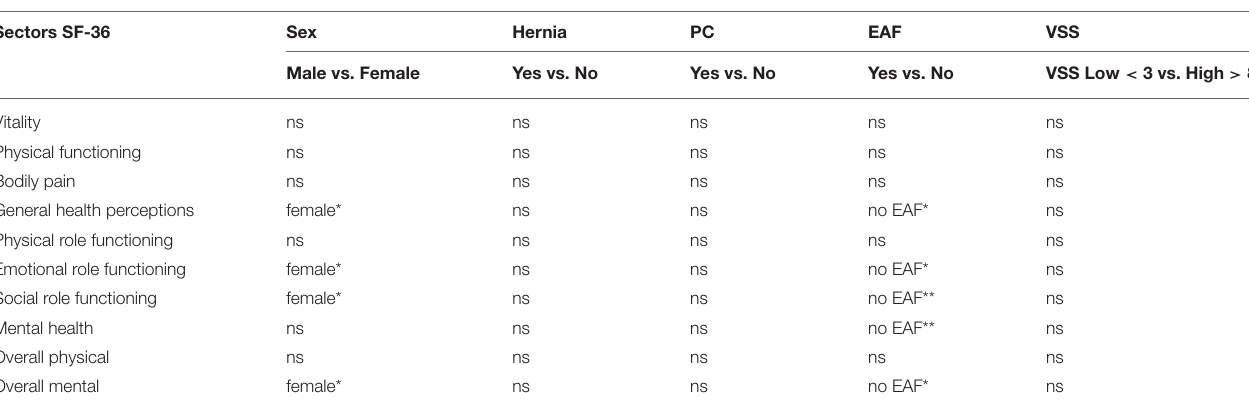
TABLE 2 | Analysis of clinical findings impacting on